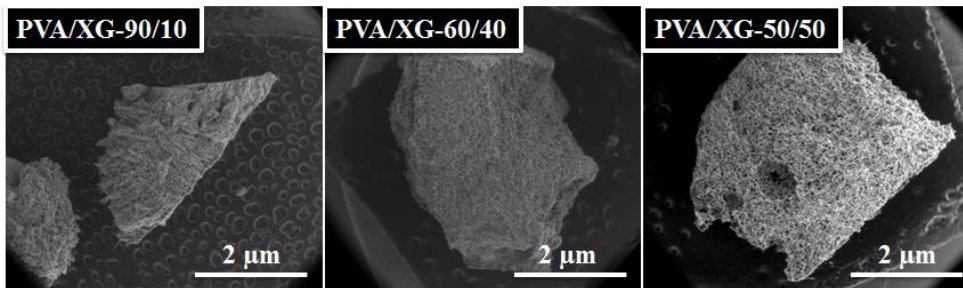
Figure 5. SEM images of investigated samples.